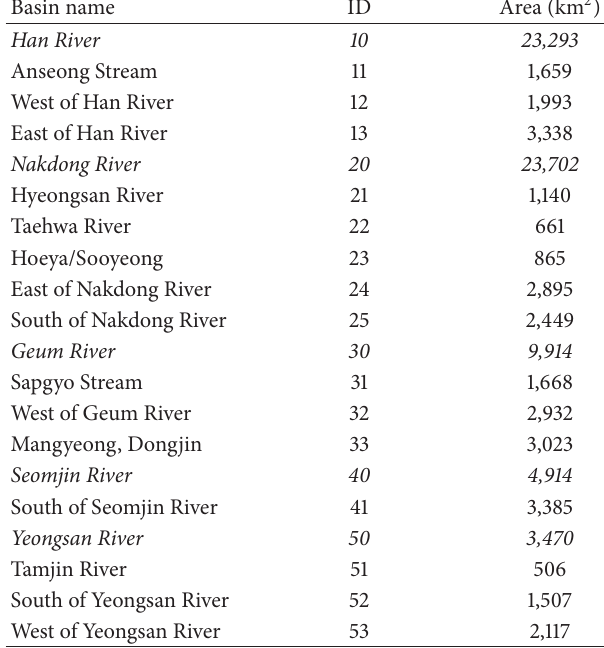
Table 1: Weather stations of the KMA used in this study. Code